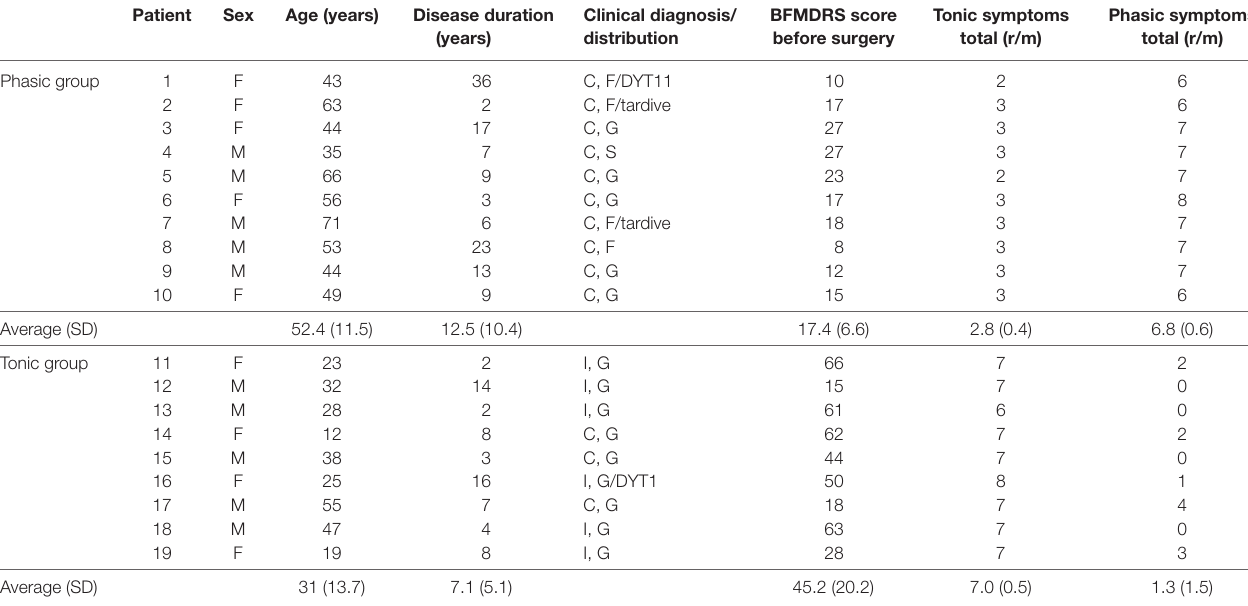
TaBle 1 | Clinical details of patients with predominant phasic and tonic symptoms of dystonia. Patient sex age (years) Disease duration